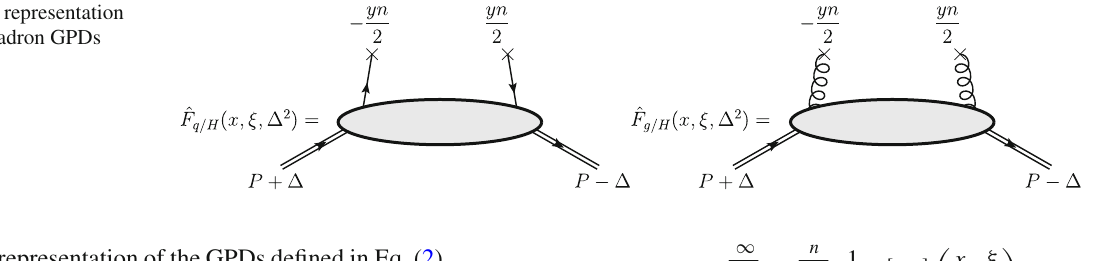
A graphical representation of the GPDs defined in Eq.